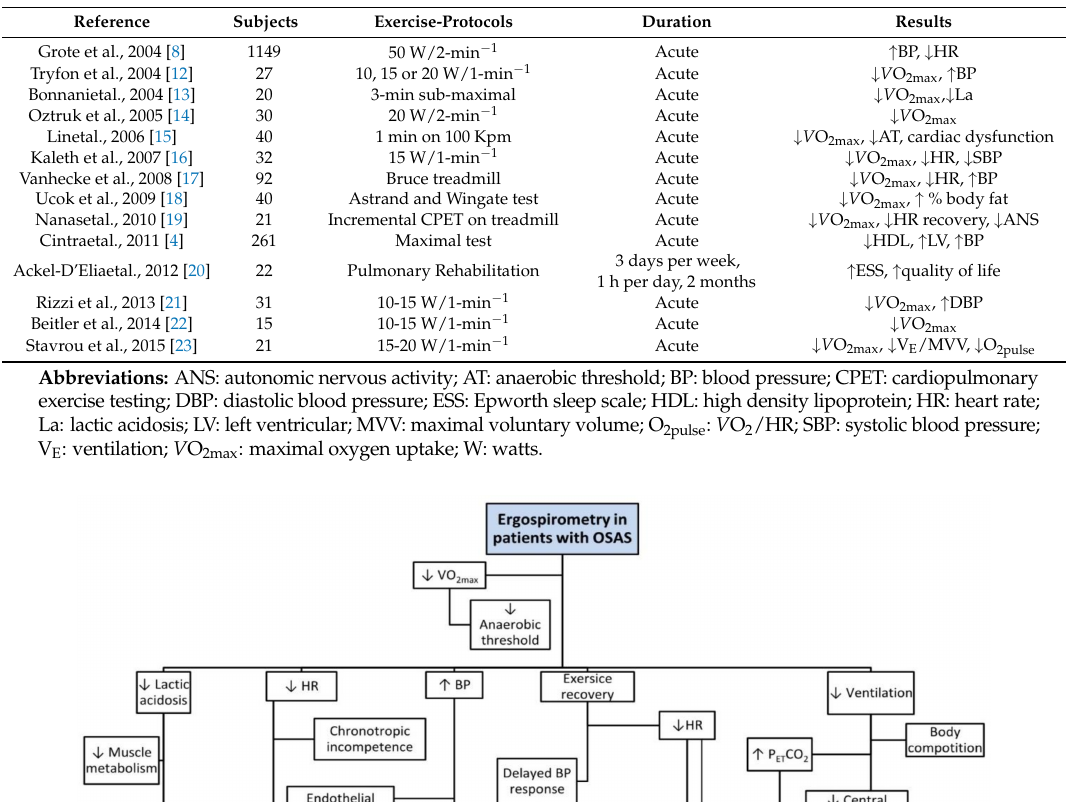
Table 1. Presenting research results in patients with OSAS during ergospirometry.